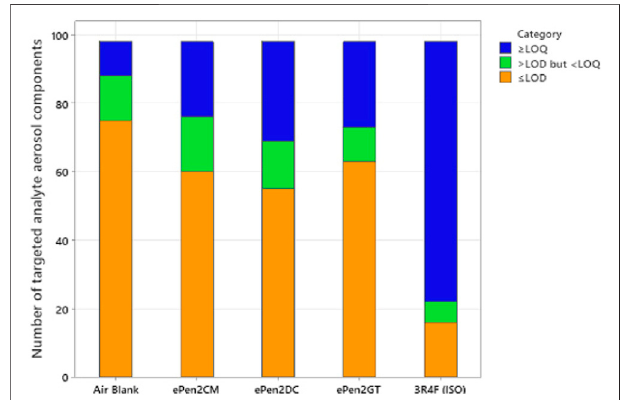
FIGURE 1 | Number of targeted aerosol compounds in the three e-cigarette fl avor variants, the air blank and the Ky3R4F cigarette (smoked underISOconditions).Thecomponentsarecategorisedaccordingtowhether their concentrations were quanti fi able ( > LOQ), detectable but not quanti fi able ( > LOD but < LOQ) or not detectable ( <